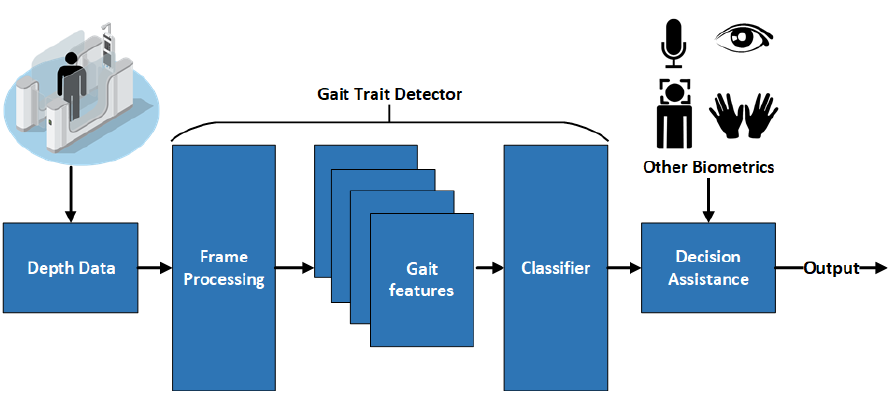
Figure 1. Architecture of the proposed framework and fusion for biometric screening enabled